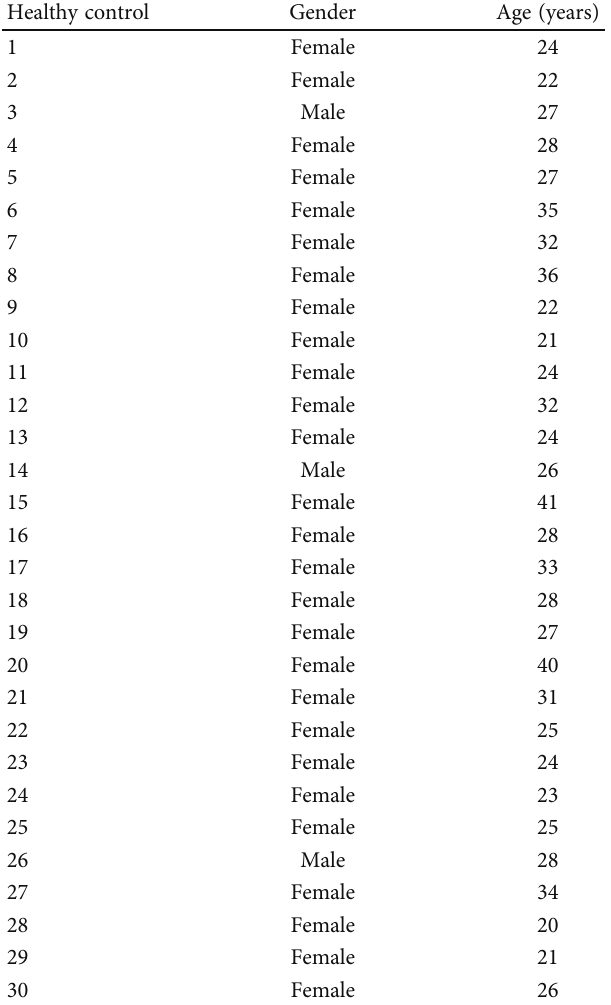
Table 2: Pro fi les of healthy controls. Healthy